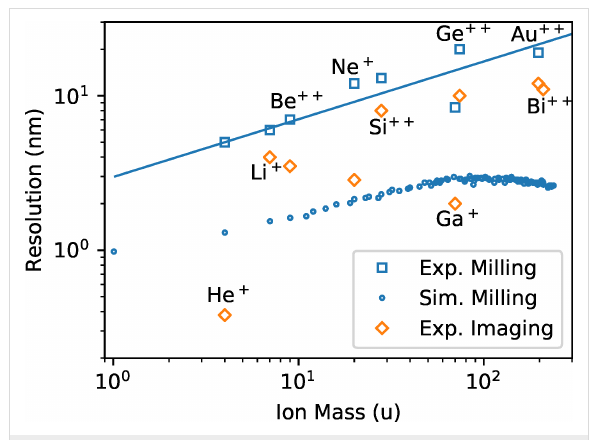
Figure 4: Summary of the imaging resolution (80/20), experimentally achieved trench width, and simulated minimum milling width (FWHM) for FIBs working with different ion species and technologies depending on the ion mass. The line serves as a guide to the eye.